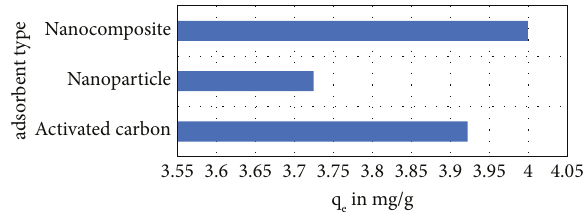
Figure 20: Effect of adsorbent type on the adsorption of dieldrin onto nanocomposite (adsorbent dosage � 0.1g/20mL, pH � 7.0, contact time � 120min, temperature 27 ° C).